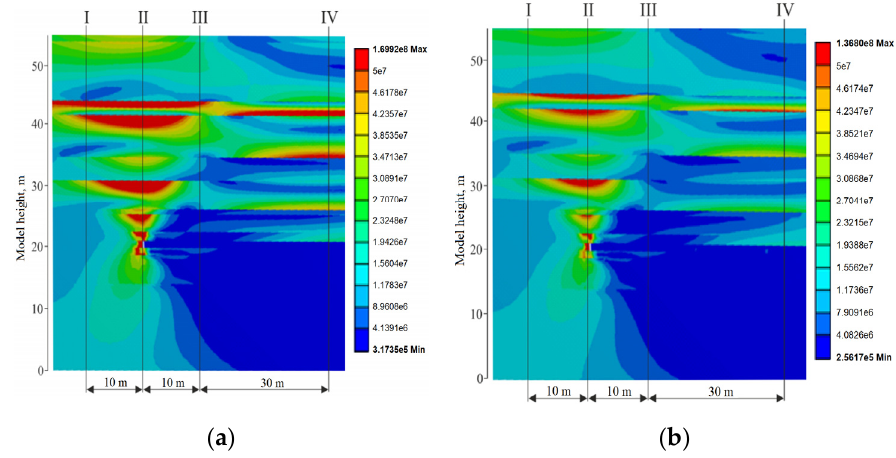
Figure 4. Curves of stress intensity σ around the longwall face: ( a ) Using traditional technology with complete caving of the roof rocks; ( b ) Using selective technology with leaving the rocks in the mined ‐ out space ( Δ m rp = 0.5); I–IV are location of sections along the model.